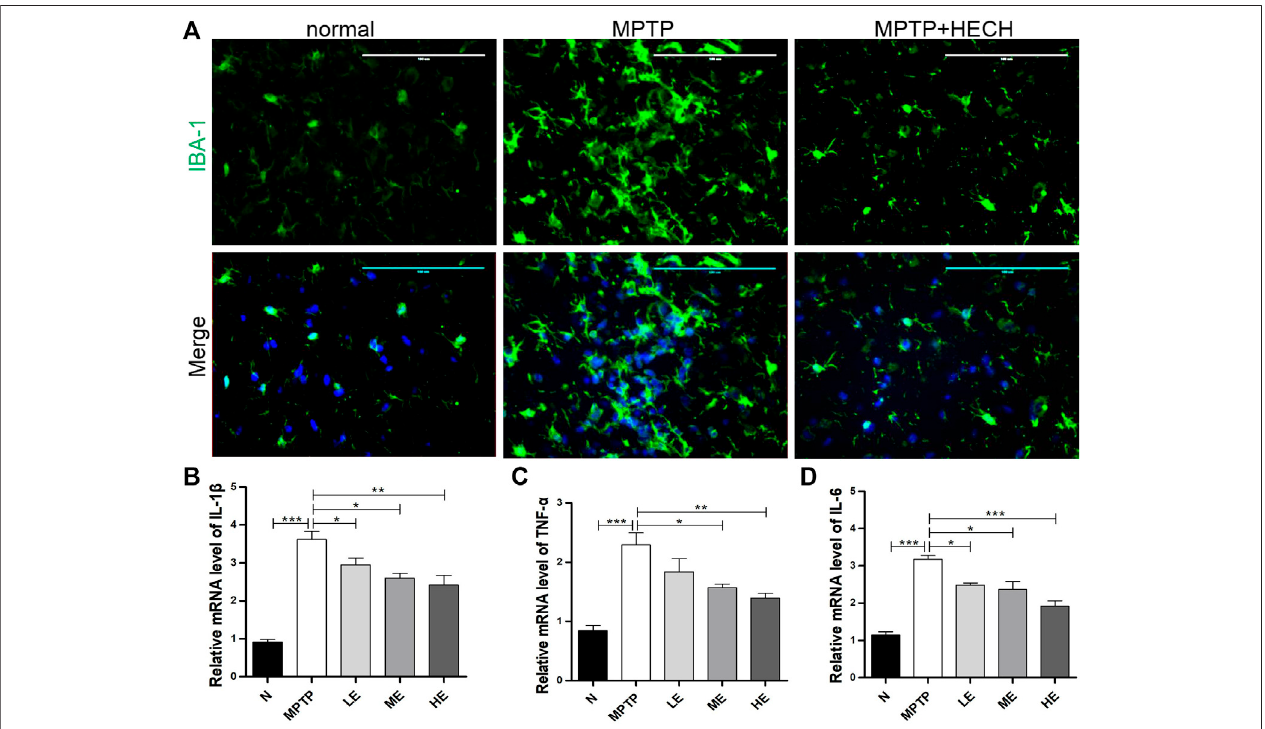
FIGURE 3 | ECH inhibited the activation of microglia and secretion of in fl ammatory cytokines in SN of MPTP mice. (A) Representative photos of immuno fl uorescence staining of IBA-1 in the striatum. (B) Relative mRNA level of IL-1 β in SN of different groups. (C) Relative mRNA level of TNF- α in SN of different groups. (D) Relative mRNA level of IL-6 in SN of different groups. Values are presented as the mean ± SEM. * p < 0.05, ** p < 0.01, *** p <